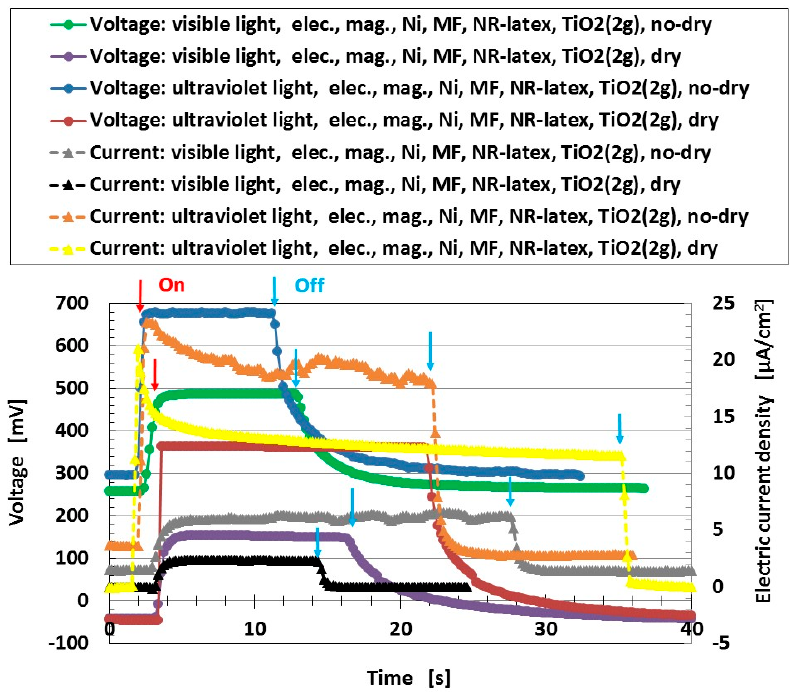
Figure 2. Changes in voltage and electric current density by turning visible and ultraviolet lights on (indicated by red arrow) and off (indicated by blue arrow). “elec.,” electrolytic polymerization; “mag.”, with the magnetic field at electrolytic polymerization; “no-dry,” dye and electrolyte are deposited right before measurement of photoelectricity for wet-type MCF rubber solar cell; “dry,” dye and electrolyte are deposited on MCF rubber after drying it for dry-type MCF rubber solar cell. Each color indicates a component of the MCF rubber solar cell with ruthenium complex dye and electrolyte KI + I 2 .